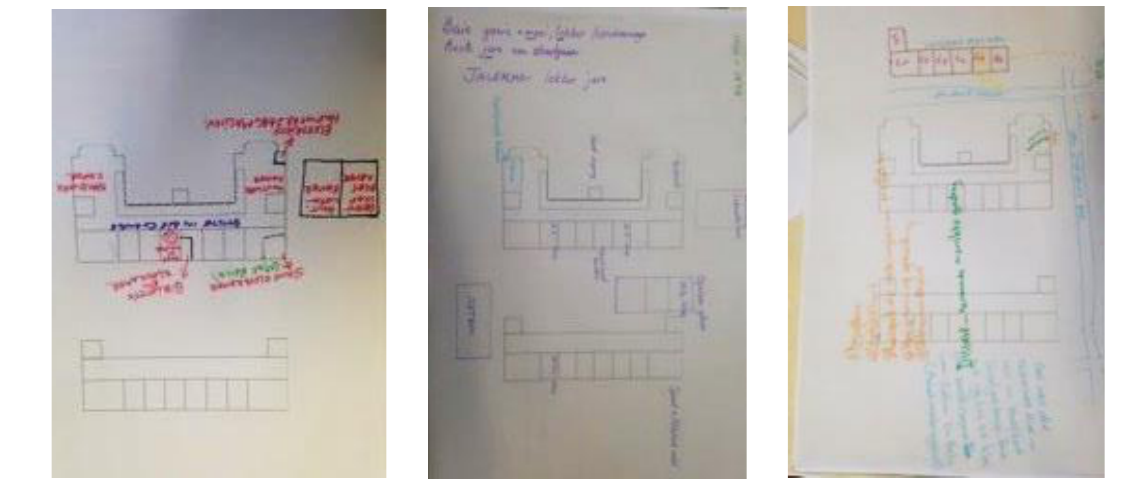
Figure 19 : Examples of the participants’work at the Lückhoff School